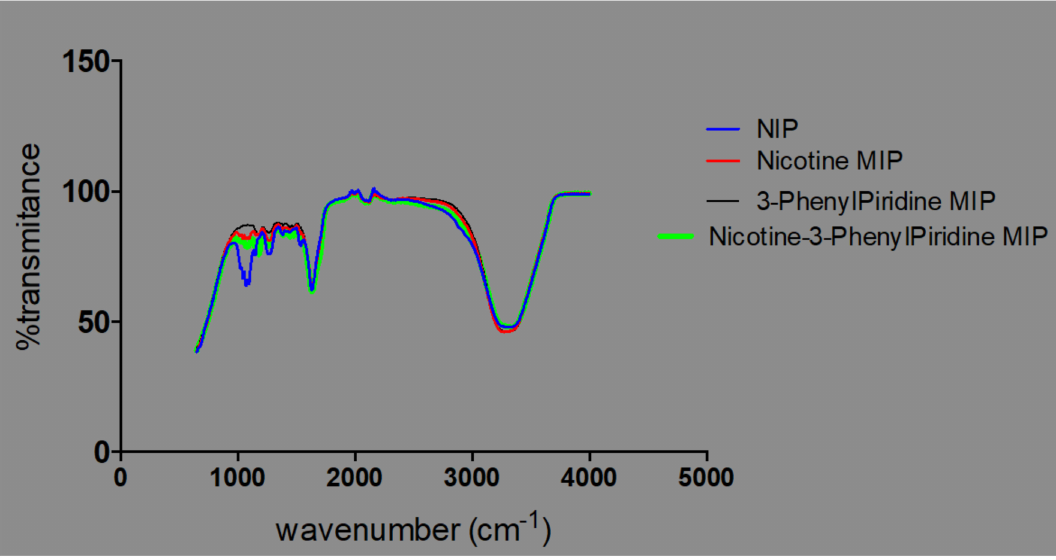
Figure 6. Plot of transmittances against % intensities for NIP- and MIP-containing